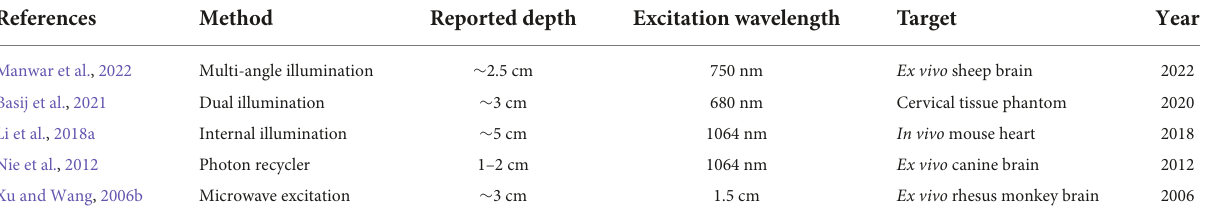
TABLE 2 Summary of illumination techniques for improving penetration depth in PAI of